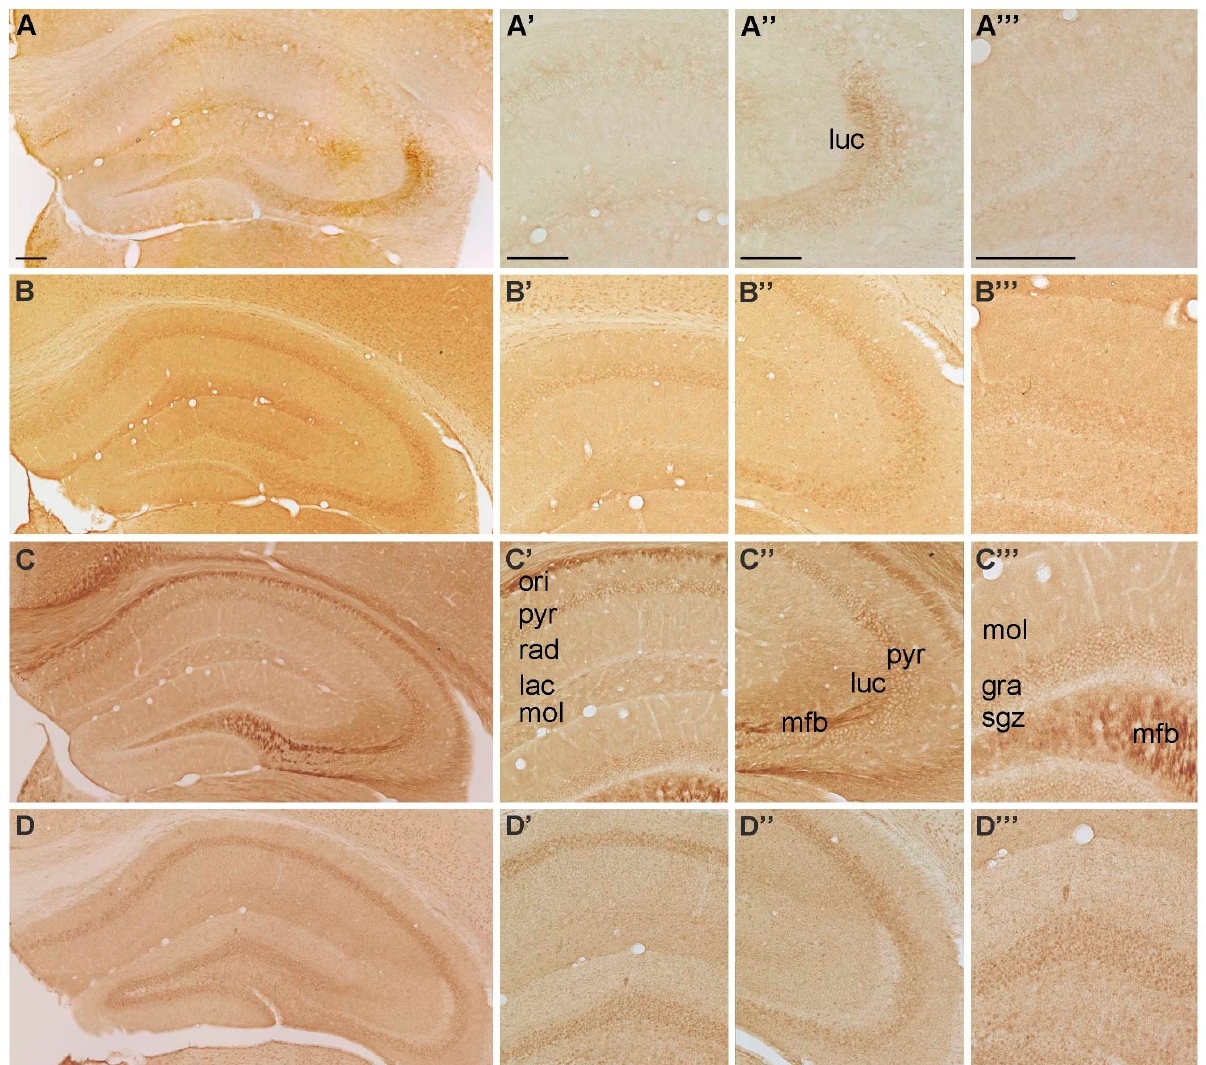
Figure 1. Representative microphotographs of ( A ) P2X1-, ( B ) P2X2-, ( C ) P2X3 and ( D ) P2X4-IR in the mouse hippocampus. At higher magnification (A’) P2X1-IR in cornu ammonis (CA) 1, ( A” ) P2X1-IR in cornu ammonis (CA) 3, ( A”’ ) P2X1-IR in dentate gyrus, ( B’ ) P2X2-IR in cornu ammonis (CA) 1, ( B” ) P2X2-IR in cornu ammonis (CA) 3, ( B”’ ) P2X2-IR in dentate gyrus, ( C’ ) P2X3-IR in cornu ammonis (CA) 1, (C” ) P2X3-IR in cornu ammonis (CA) 3, ( C”’ ) P2X3-IR in dentate gyrus, ( D’ ) P2X4-IR in cornu ammonis (CA) 1, ( D” ) P2X4-IR in cornu ammonis (CA) 3 and ( D”’ ) P2X4-IR in dentate gyrus, respectively. Abbreviations: ori, stratum oriens, pyr, stratum pyramidale, rad, stratum radiatum; lac, stratum lacunosum; mol, stratum moleculare; luc, stratum lucidum; mfb, mossy fiber bundle; gra, stratum granulare, sgz, subgranular zone. Scale bars = 200 µm.